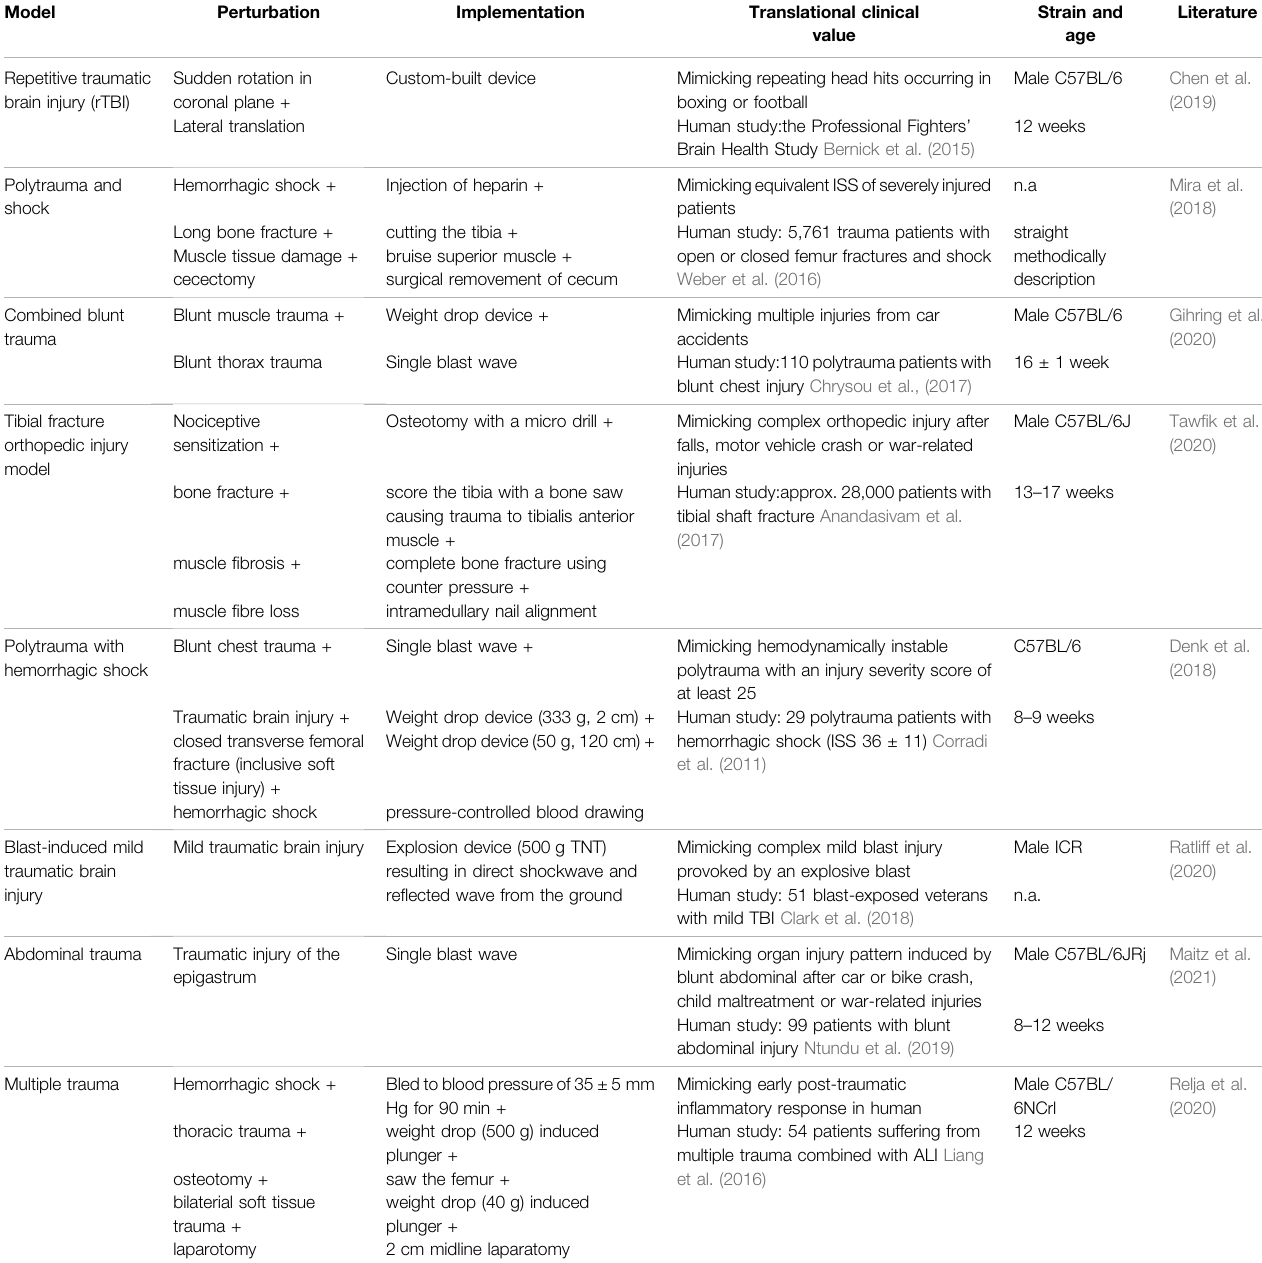
TABLE 1 | Summary of trauma mouse models with a speci fi c focus on clinical relevance by implementing additional aspects to add to translational clinical value.